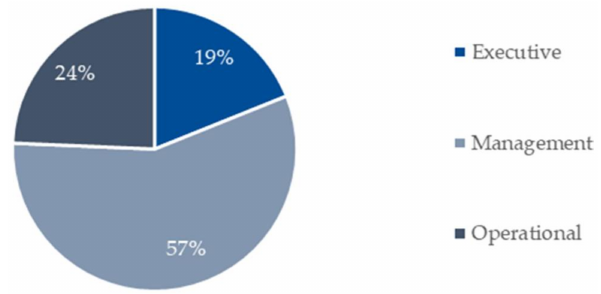
Figure 6. Distribution of respondents’ positions ( n =